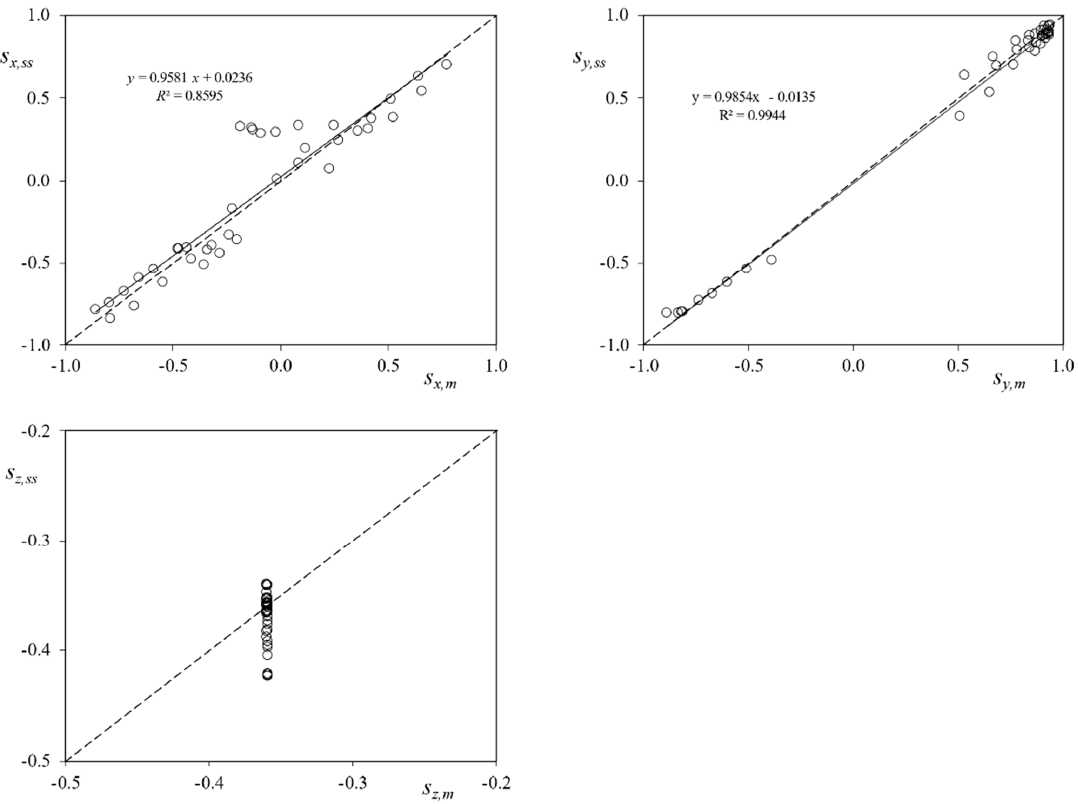
Figure 16. Albedo filtered sun direction coordinates with regard to the UPMSat-2 reference system. Coordinates based on the sun sensors system ( s x,ss , s y,ss , and s z,ss ) vs. coordinates based on the magnetometers of the satellite’s ADCS ( s x,m , s y,m , and s z,m